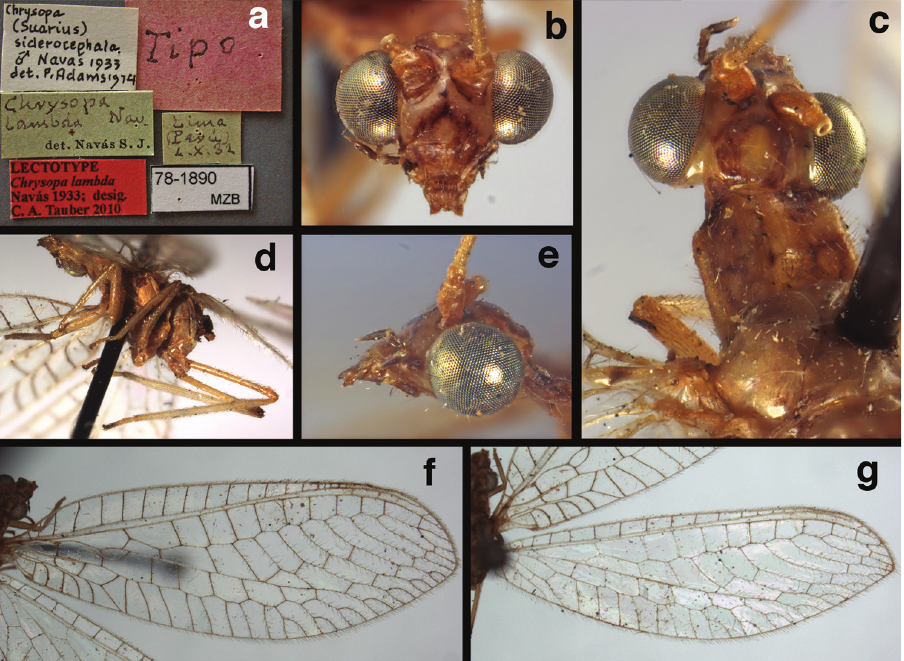
Figure 83. Chrysopa lambda Navás: External features, ( a ) labels ( b ) head, frontal ( c ) head, prothorax, dorsal ( d ) thorax, lateral ( e ) head, lateral ( f ) forewing ( g ) hindwing (Peru, Lima, lectotype, male, MZBS). tentorial pits surrounded by reddish brown. Antenna with scape, pedicel reddish, un- marked; flagellum cream-colored; maxillary palp, labial palp with two basal segments pale, other segments dark